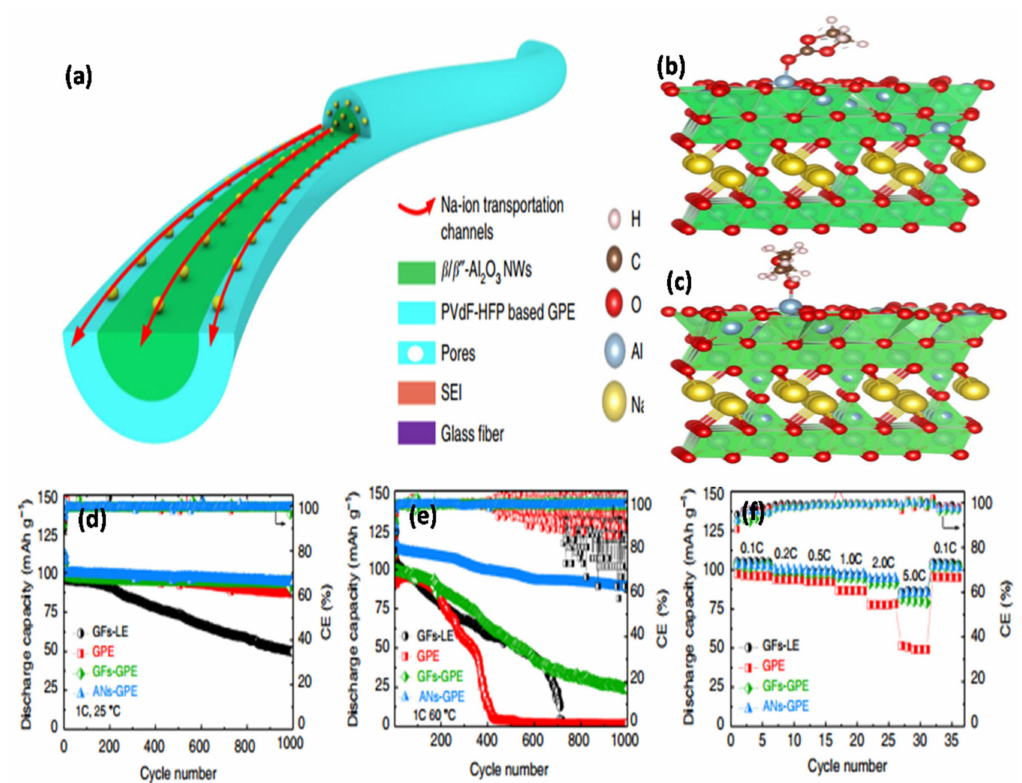
Figure 12. ( a ) Schematic of Na-ion transportation in the Al 2 O 3 nanowire (AN)-GPE. ( b , c ) Adsorption of ethylene carbonate (EC) and diethylene carbonate (DEC) on the β -Al 2 O 3 (003). ( d , e ) Cyclic performance of the Na 3 V 2 (PO 4 ) 3 (NVP)/Na cells using a glass fiber (GF)-LE, GPE, GFs-GPE, and ANs-GPE at 1 C under 25 and 60 ◦ C, respectively. ( f ) Rate performance of the NVP/Na cells using the different GPEs. Reprinted with permission from Yang et al. [104]. Copyright 2019 Springer